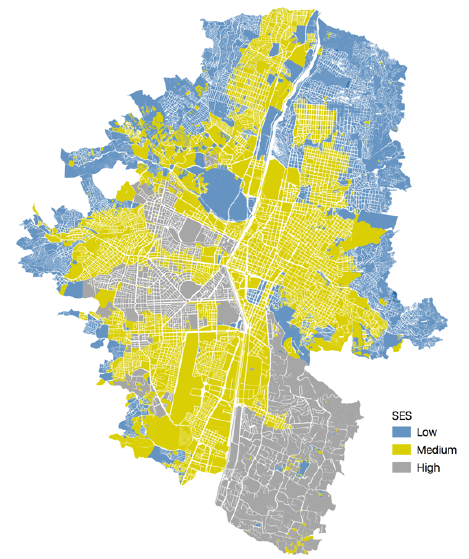
Figure 2. Urban area of Medellin by